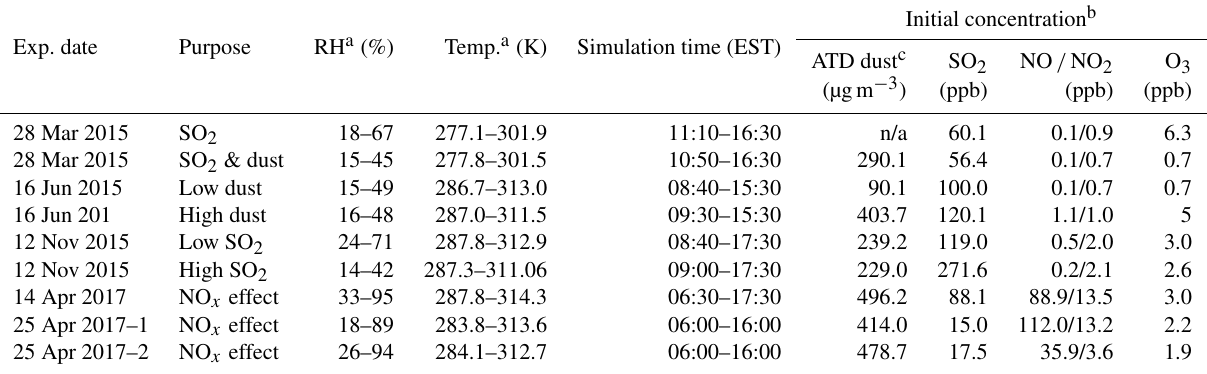
Table 2. Outdoor chamber experiment condition for SO 2 heterogeneously photooxidation on the ATD particles at variety initial concentration of SO 2 , dust particle, and NO x .